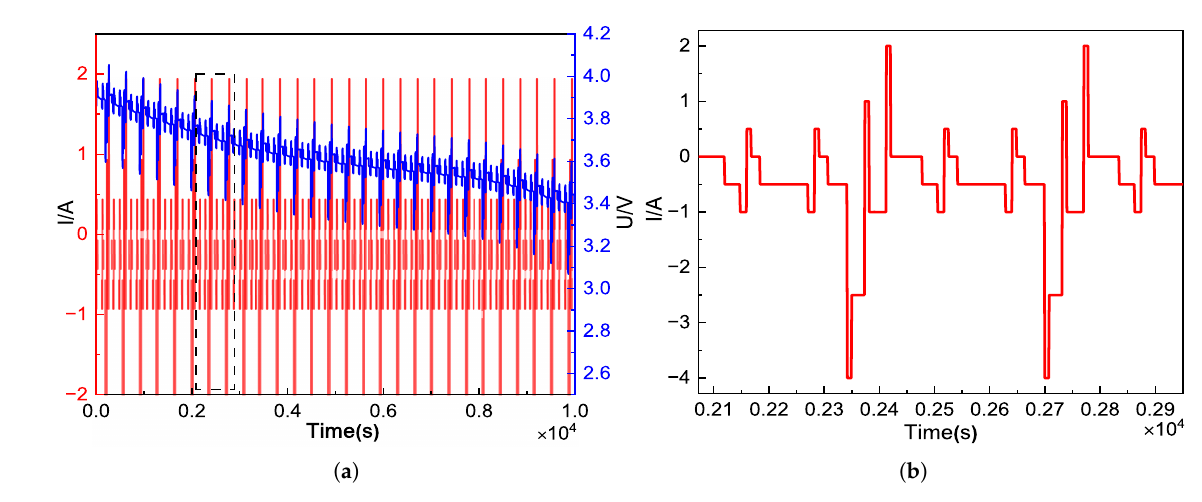
Figure 13. Complete DST curve and current amplification curve in DST: ( a ) current, ( b ) current am- plification.